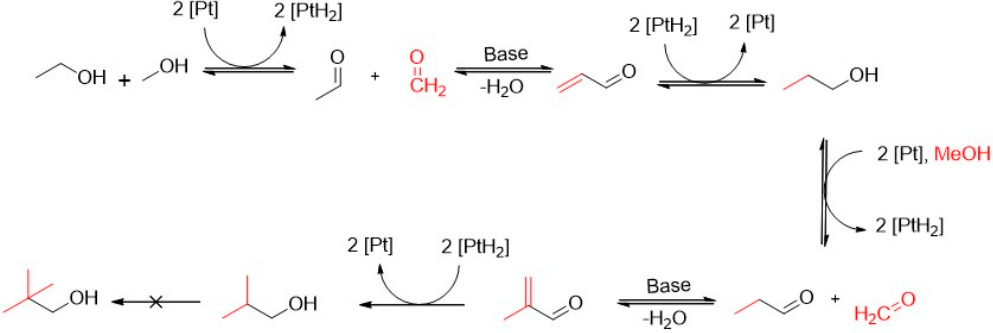
Figure 1. Reaction pathway for the synthesis of iso-butanol from ethanol and methanol.